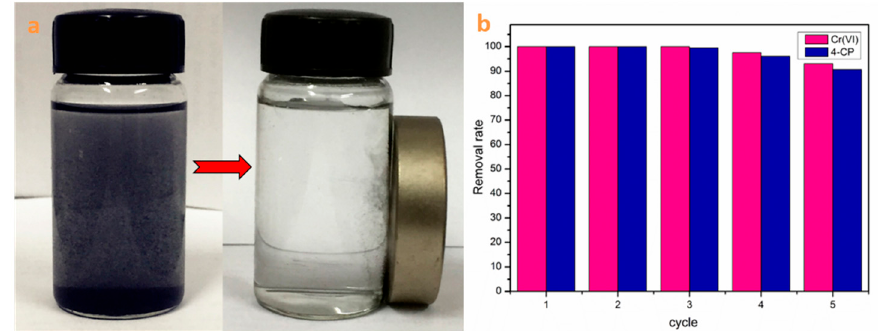
Figure 13. ( a ) Photographs of the nanocomposites in aqueous solution before ( left ) and after ( right ) the placement of a magnet. ( b ) The reusability of MFNNs for the removal of Cr(VI) in 15 min and 4-CP in 60 min. (Experiment conditions: [Cr(VI)] 0 = 10.0 mg/L, [4-CP] 0 = 100.0 mg/L, [MFNNs] = 0.20 g/L, [H 2 O 2 ] 0 = 4.90 mM, pH =